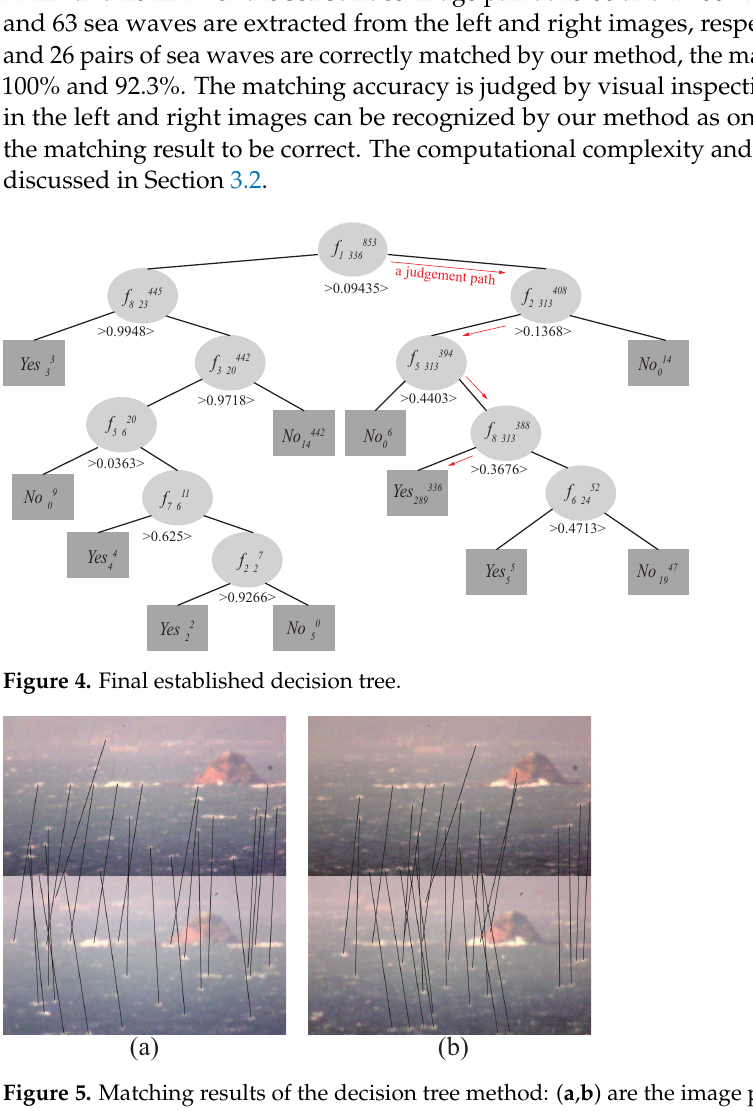
Figure 5. Matching results of the decision tree method: ( a , b ) are the image pairs taken at 15:00 and 17:00, the top is taken by left camera and the bottom is taken by right